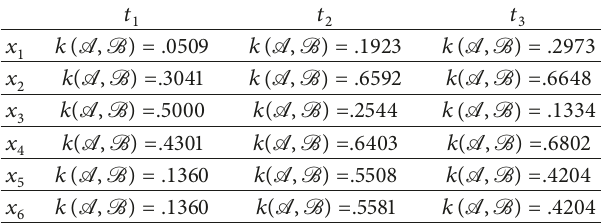
Table 6: Then 𝑘( A , B )